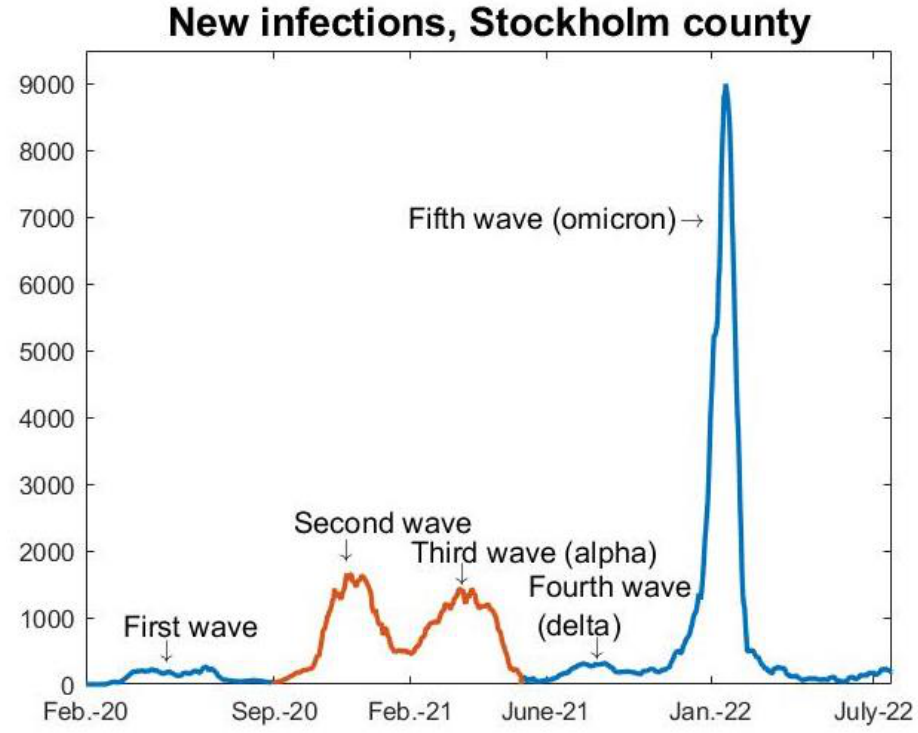
Figure 1. Full data series (weekly average) from the Swedish Public Health Agency. During first wave, only patients admitted to hospital were tested, so the data are very unreliable. General testing started in late May 2020. The red section indicates the time frame we focus on in this